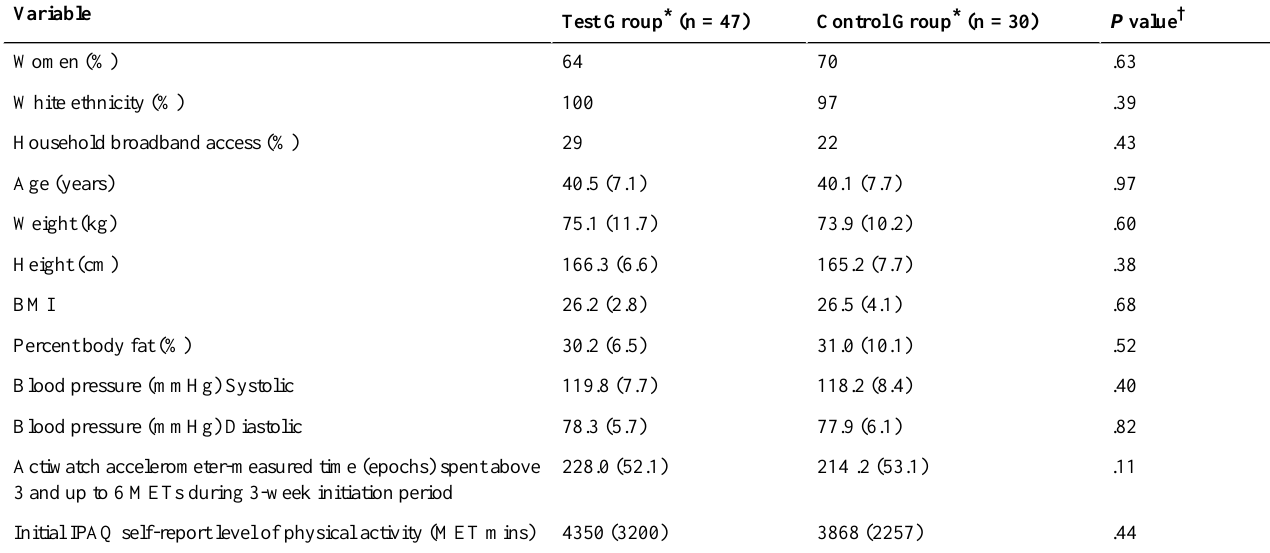
Table 1. Baseline characteristics of